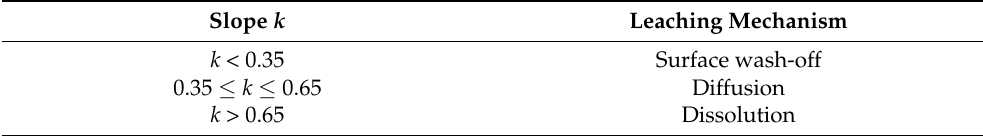
Table 2. Leaching mechanism determined by slope of fitting curve.